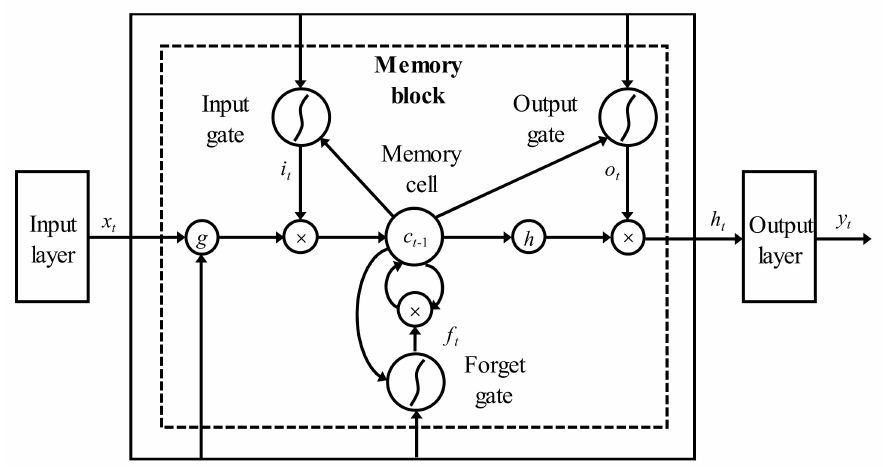
Figure 2. Architecture of LSTM neural